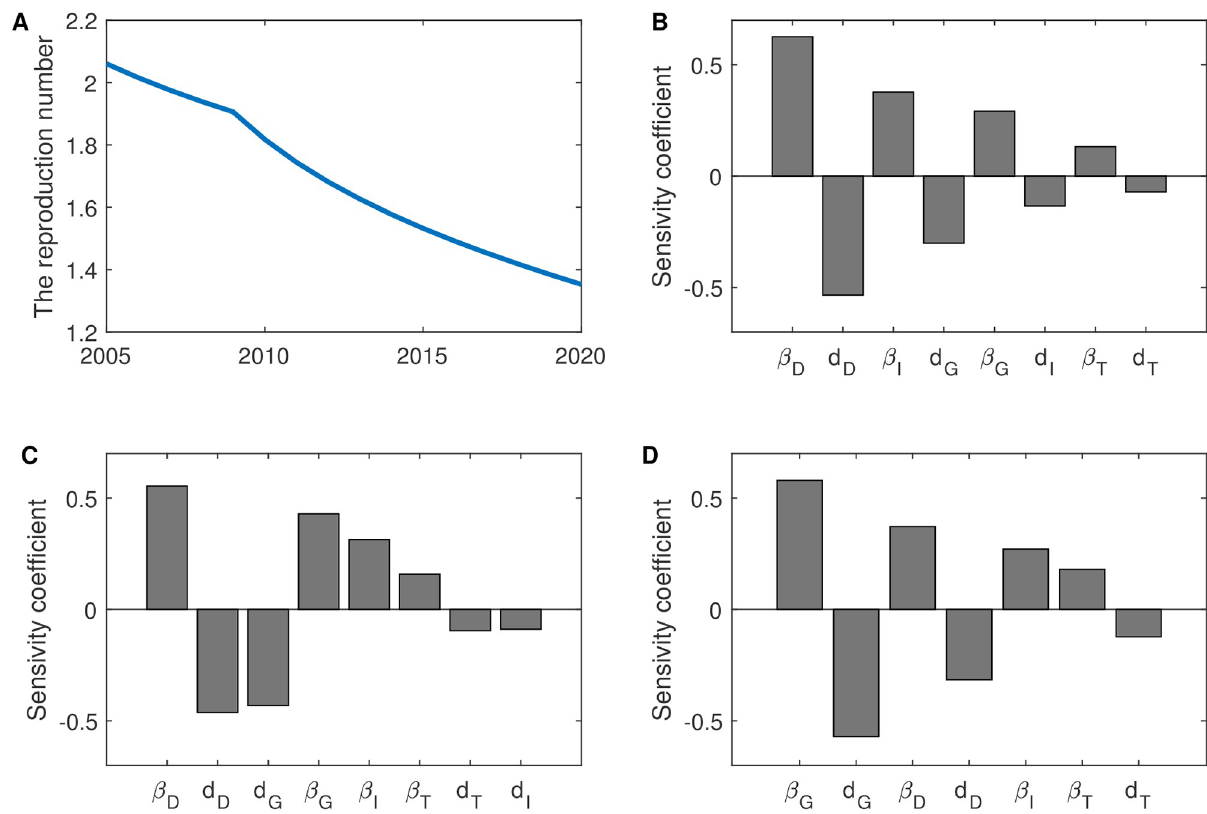
Fig 6. Estimated annual value of the reproduction number R C and its sensitivity analysis. (A) The estimated value of R C from 2005 to 2020. in 2005 (B), 2010 (C) and 2015 (D). Latin hypercube sampling was used to analyze the sensitivity of 10,000 samples. All Sensitivity analysis results of R C parameter values are the same as in Table 5.